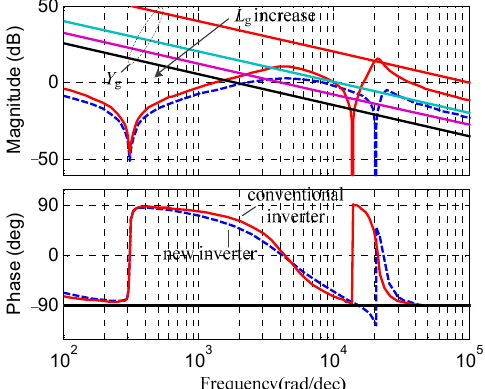
Figure 12. Interaction Bode diagrams between the inverter admittance and grid admittance for new and conventional